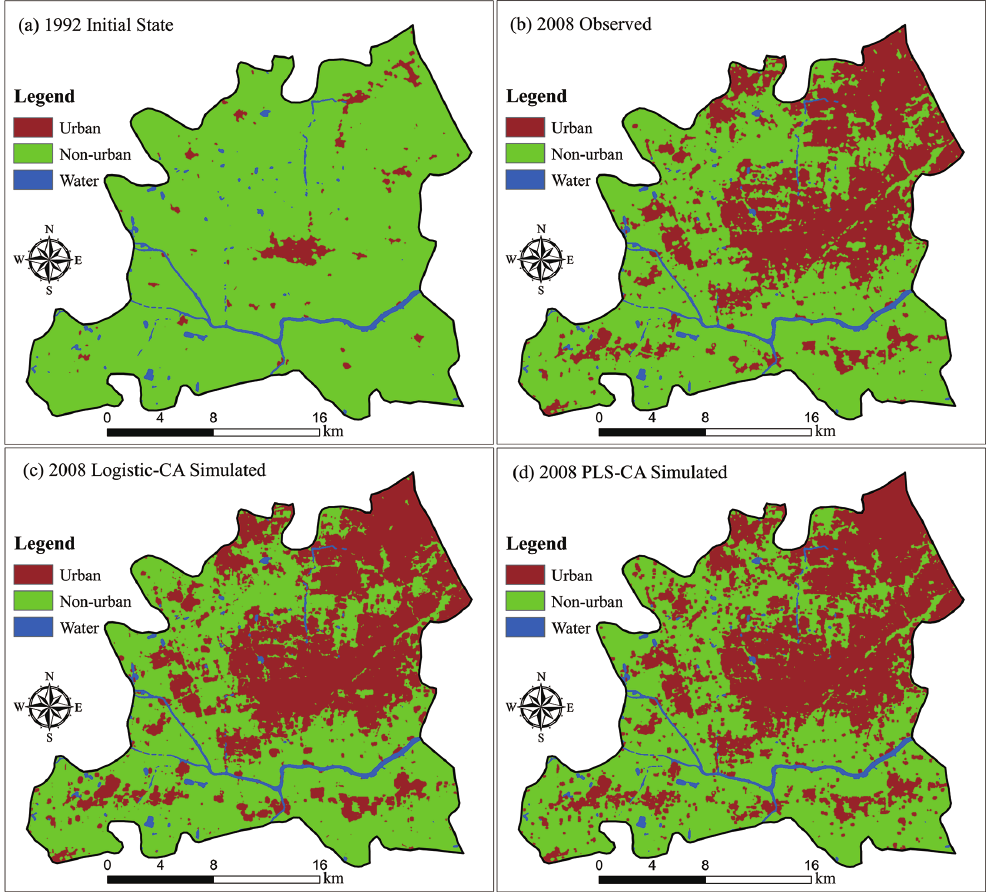
Figure 5. The observed and simulated patterns in Songjiang. ( a ) The 1992 initial state; ( b ) The 2008 observed pattern; ( c ) The 2008 simulated pattern by logistic-CA; and ( d ) The 2008 simulated pattern by PLS-CA.